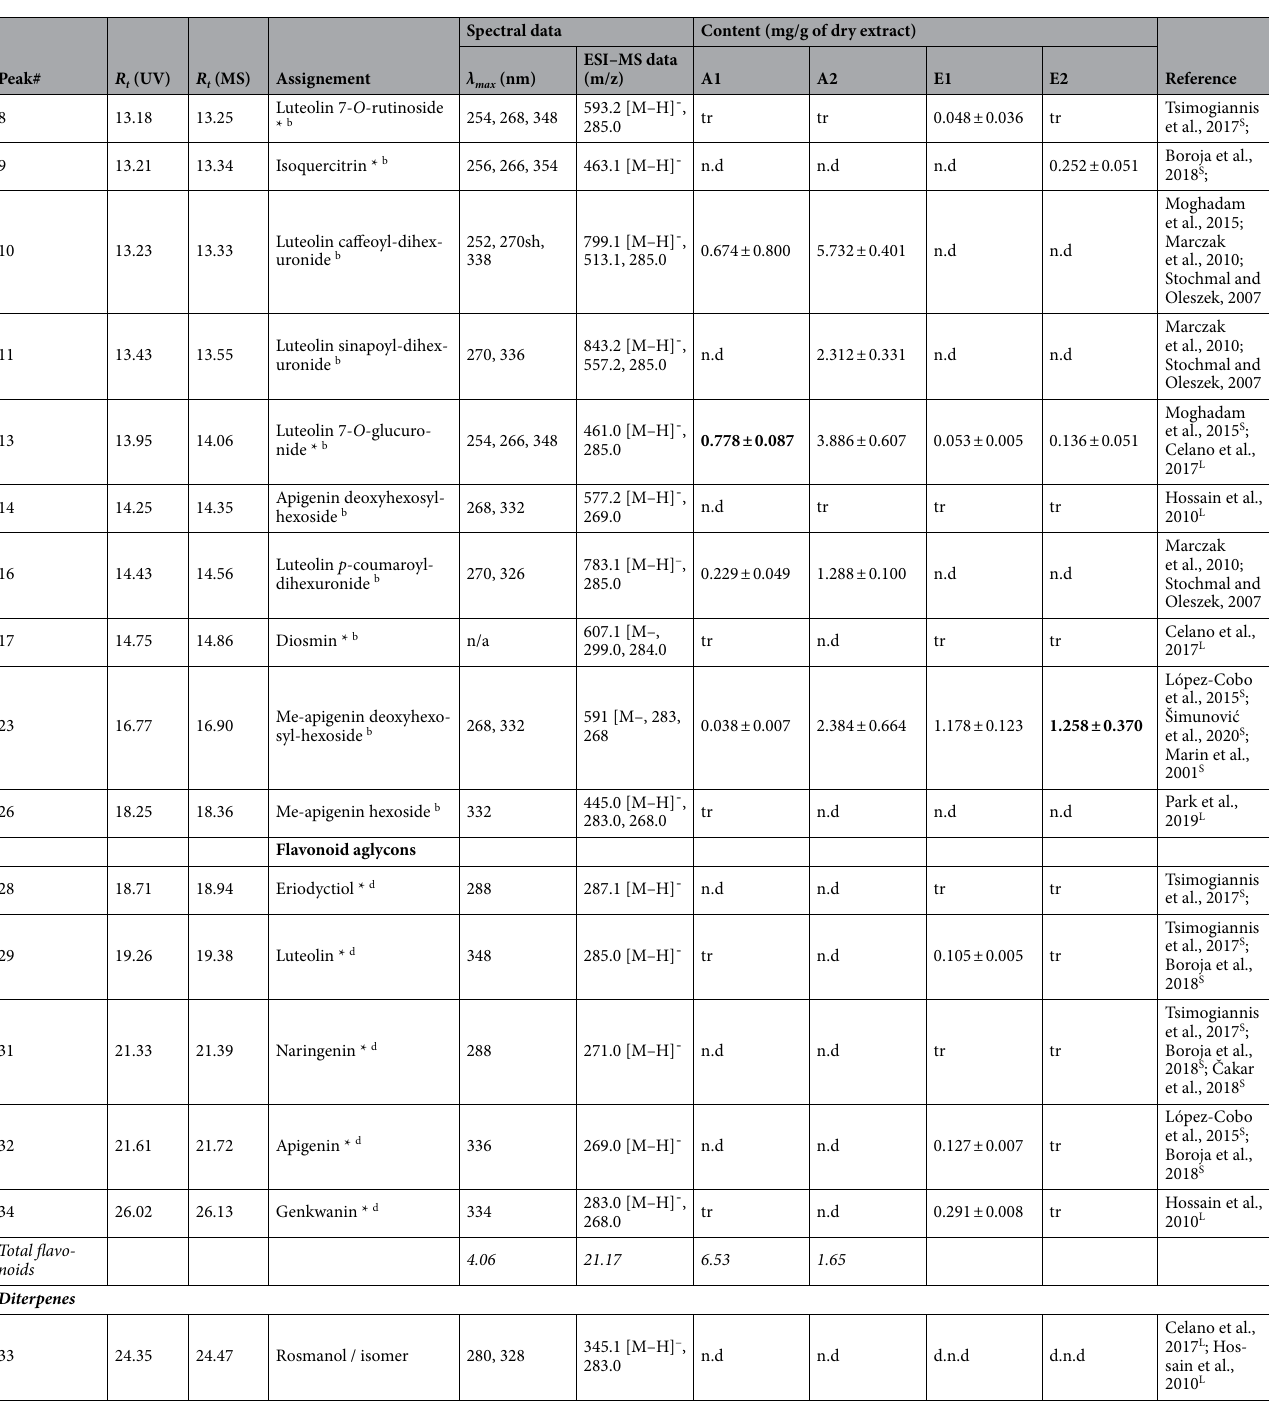
Table 1. Results of qualitative and quantitative LC–PDA/MS analysis of aqueous and ethyl acetate extracts of stems, leaves and flowers (A1 and E1, respectively) and leaves and flowers (A2 and E2, respectively) of S. kitaibelii. HCA, hydroxycinnamic acid; n/a, not available; n.d., not detected; d.n.d., detected, but not determined; tr., trace. *Constituent identified by comparison with the standard compound; S previously detected in a plant belonging to the genus Satureja ; L previously detected in a plant belonging to the family Lamiaceae. a Expressed as chlorogenic acid equivalents; b expressed as rosmarinic acid equivalents; c expressed as luteolin 7- O -glucoside equivalents; d expressed as luteolin equivalents. Major constituents in extracts are marked in bold